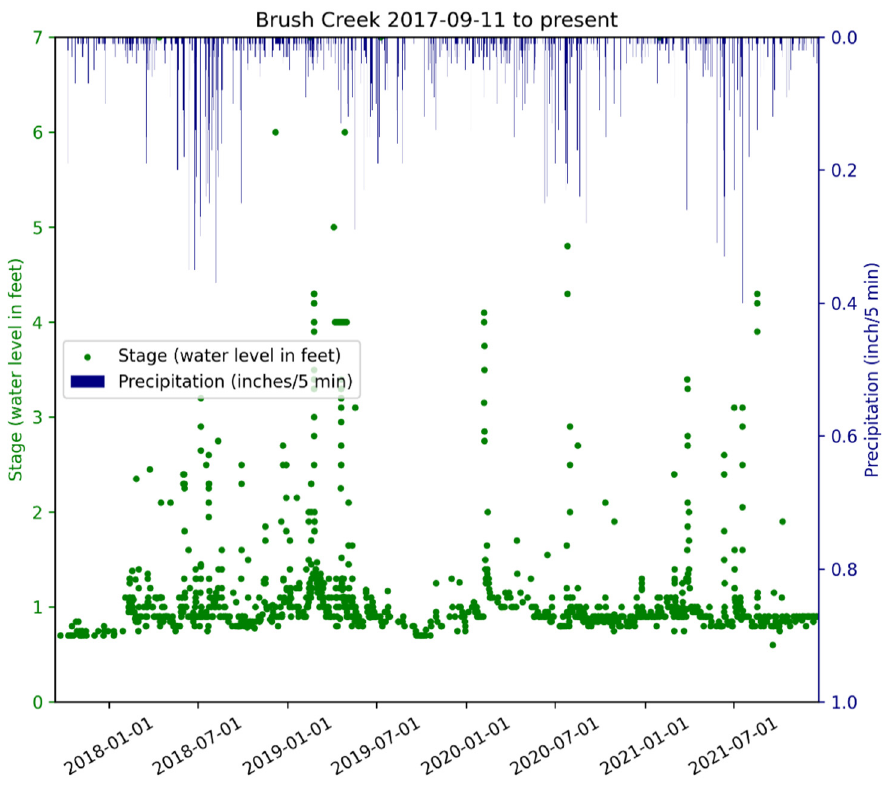
Figure 5. Example of automated plot of stage and precipitation data showing all contributed data. All plots are updated hourly and freely available online. Units are in US format (inches/feet) in all data plots intended for public use.